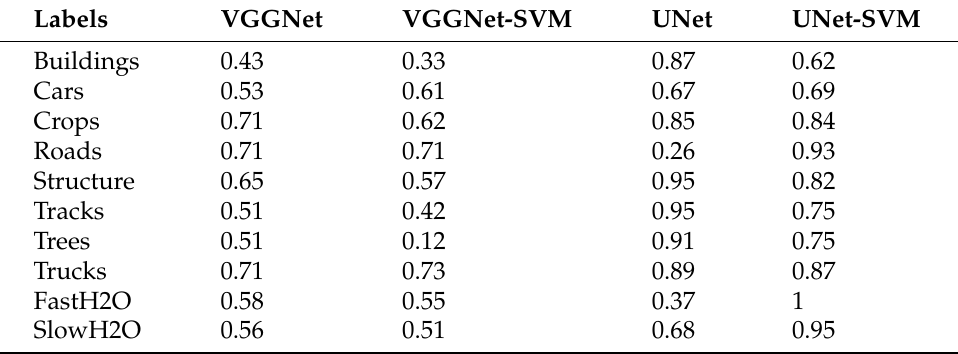
Table 4. Summary of experimental results of classification with SVM: UNet and VGGNet.